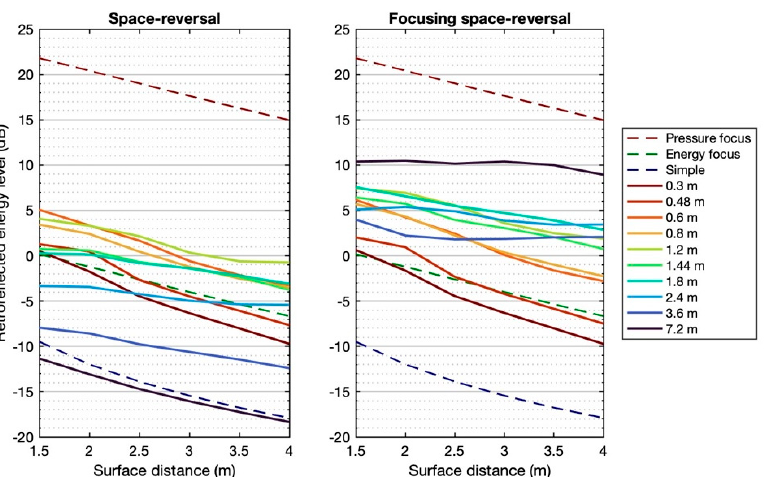
Figure 6. Spatially averaged retroreflected energy levels at collocated source-receivers for space- reversal and focusing space-reversal surface configurations. Twenty-four source-receivers are located within a 2.4 × 2.4 m square offset from the centroid of a 7.2 × 7.2 m reflector, and one is located at the focus of a 3.6 m patch. Distances from source-receiver to reflector are indicated by the x -axis. Dashed lines show theoretical expectations (Equations (2), (4) and (5)). Values are speech-A-weighted.